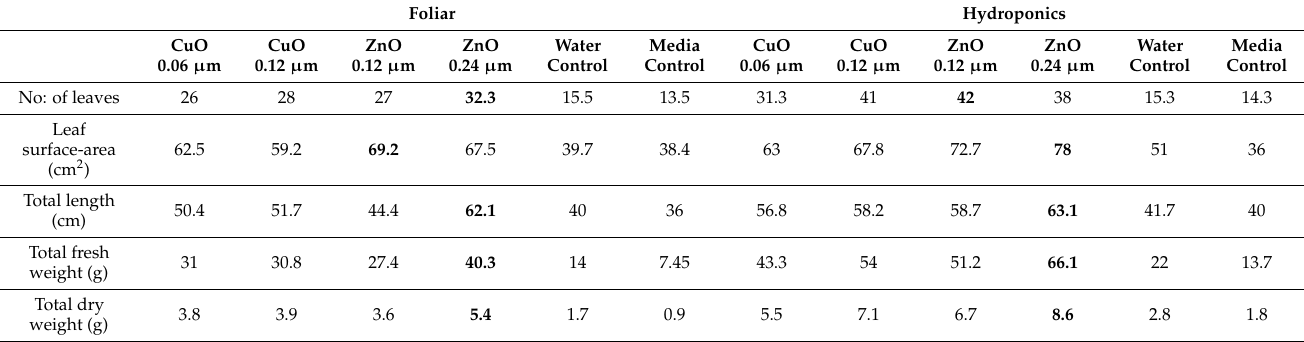
Table 2. Effect of the application of CuO and ZnO nanoparticles through hydroponic and foliar systems on the phenotypic character of Amaranthus hybridus